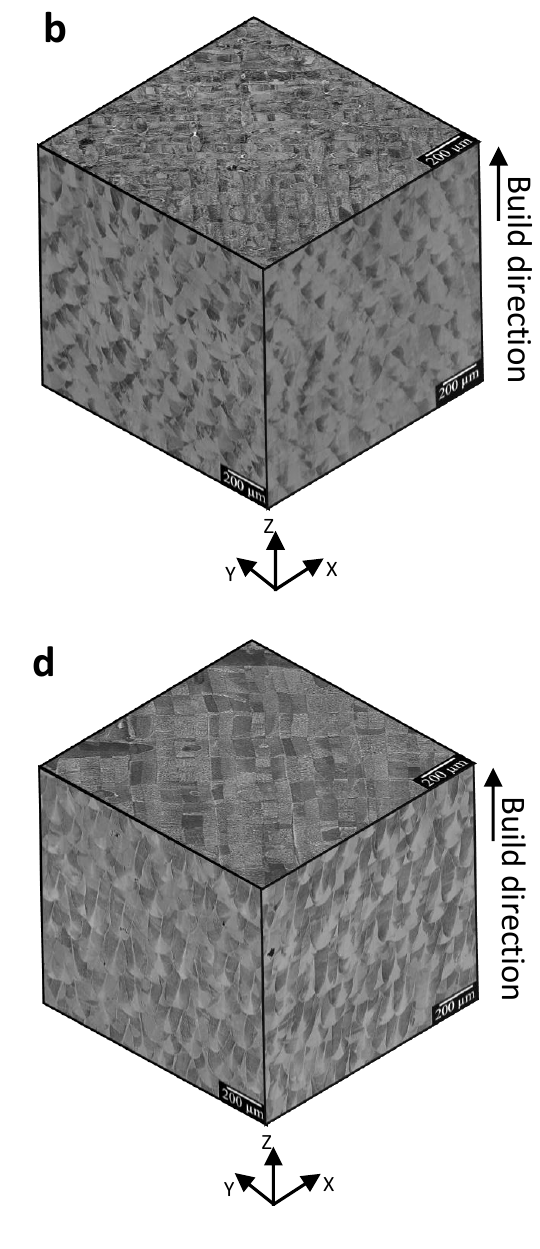
Figure 8. Representative optical microscopy images on the 3 orthogonal planes after etching the as-built 316LSS produced at ( a ) 160 W, ( b ) 240 W, ( c ) 320 W, and ( d ) 380 W.